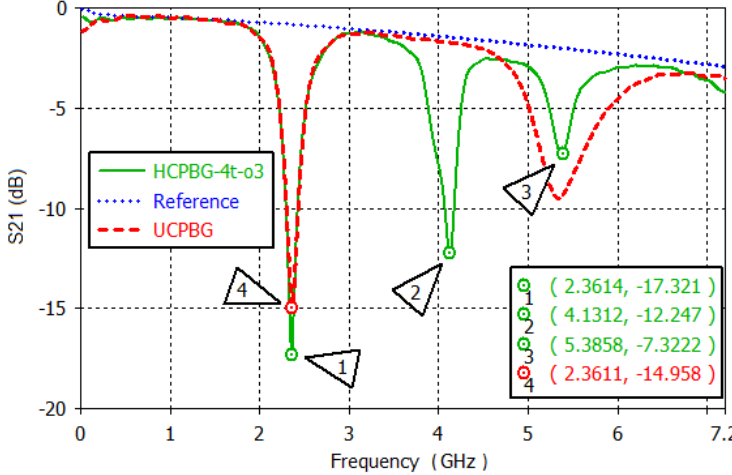
Figure 3. Simulation—transmission loss for UCPBG and